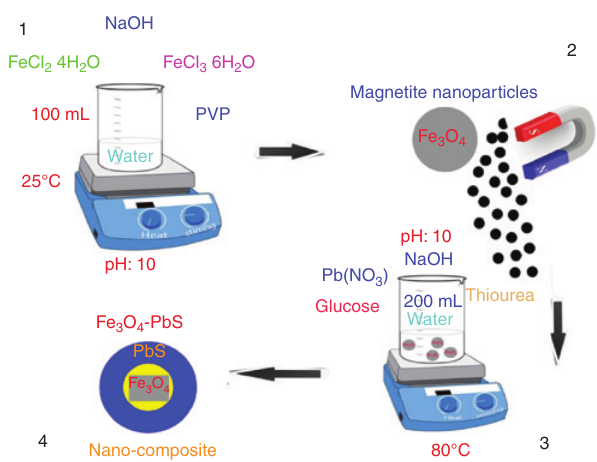
Figure 1: (1,2) Schematic of ferrite preparation (3,4) nanocomposite